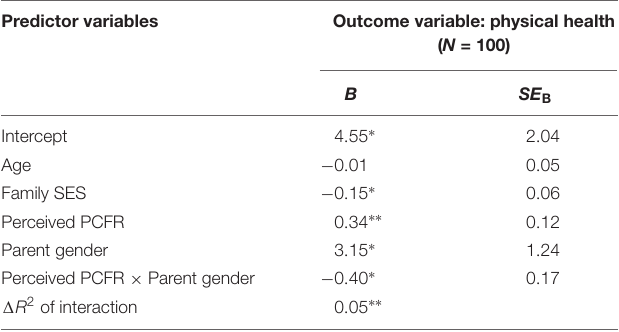
TABLE 2 | The moderating effect of parent gender on the relationship between perceived PCFR and physical health. Predictor variables